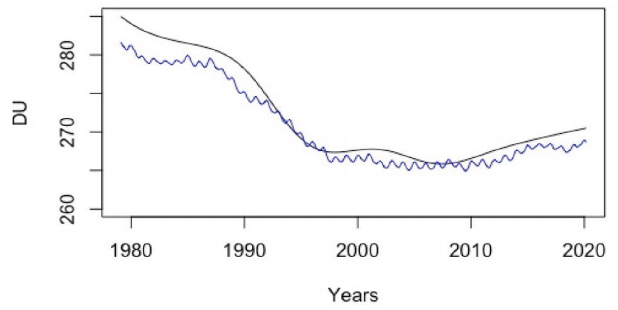
Figure 8. Trend obtained from the EEMD technique (black curve). The trend of the original signal obtained from a moving window (blue curve) with a 125-month size (i.e. 10.4